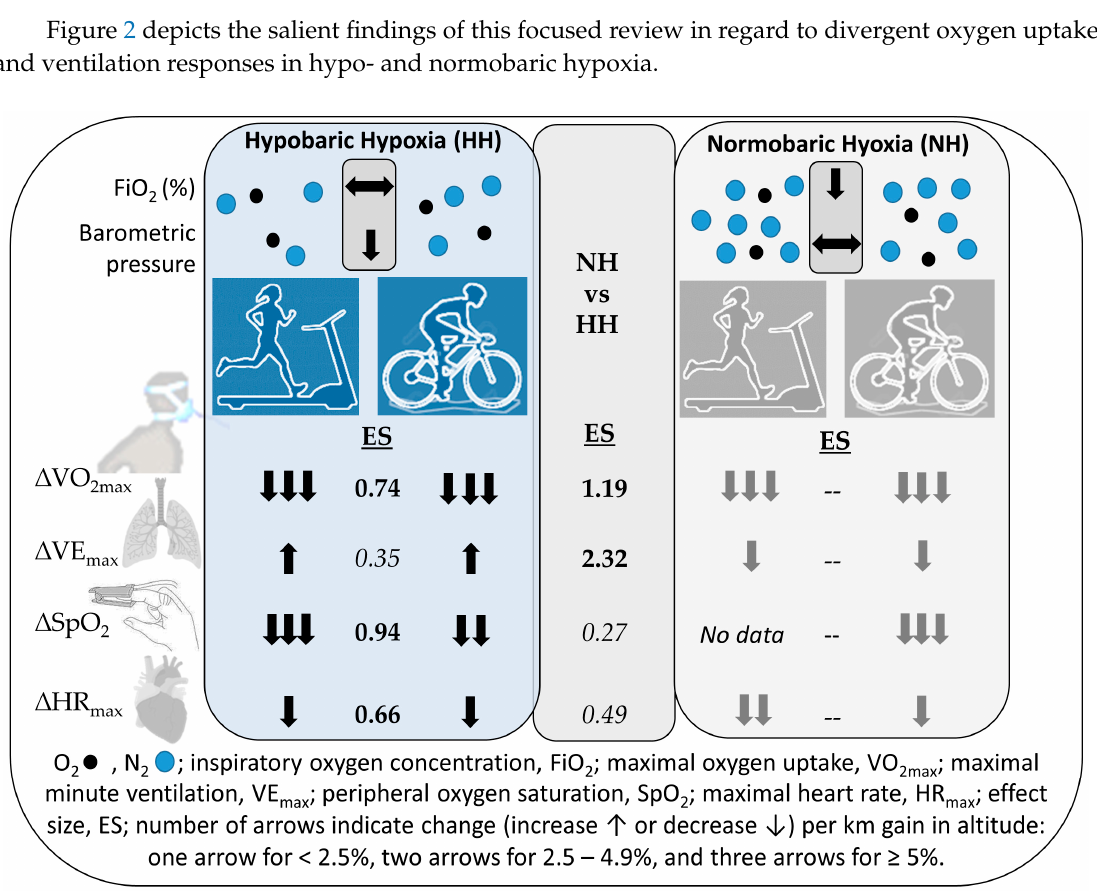
Figure 2. Schematic presentation of the key findings. E ff ect sizes for di ff erences between cycling and treadmill running could not be calculated